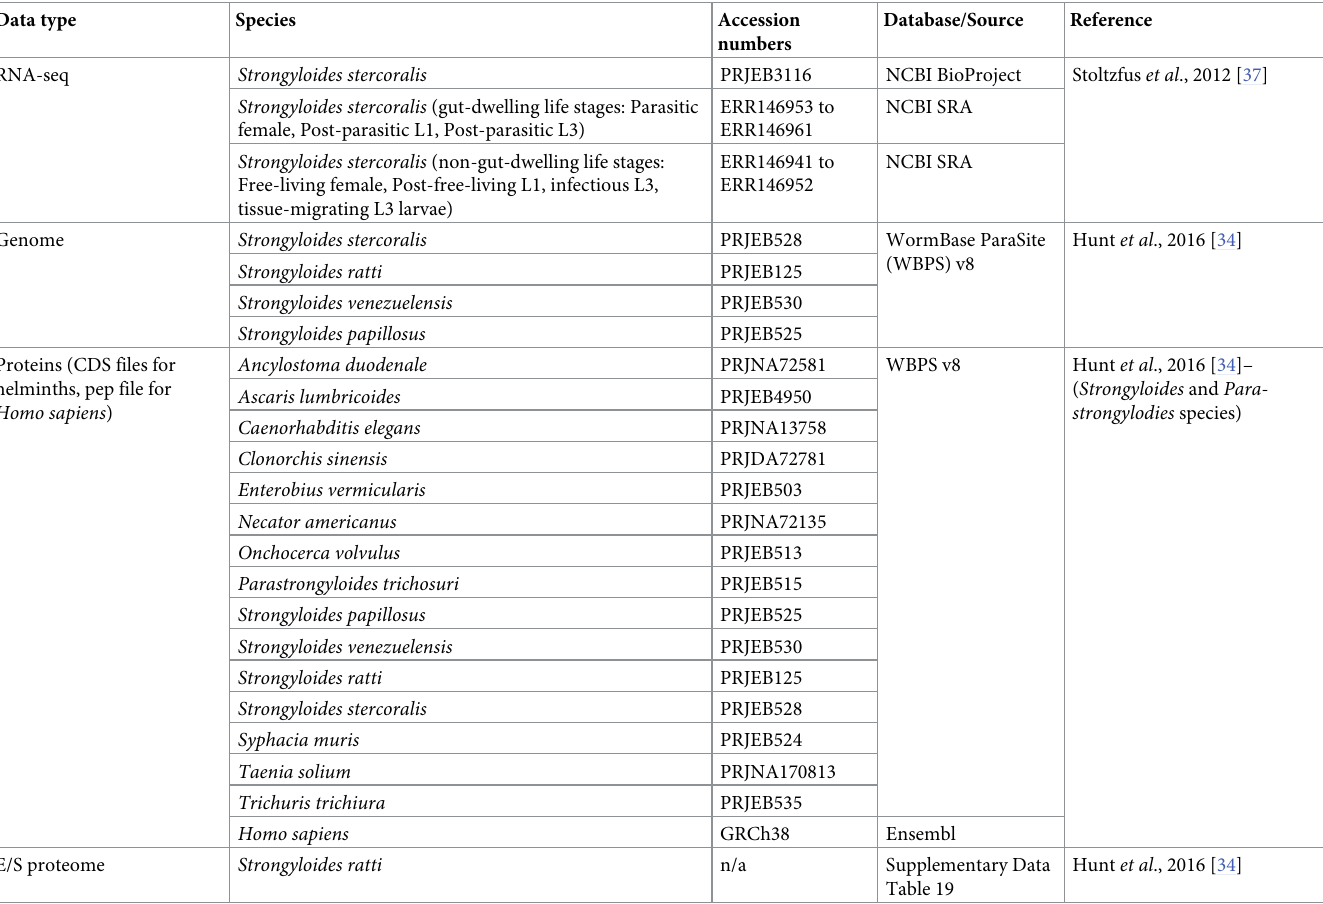
Table 1. Data used in this study. Accession numbers, source databases, and original references where used. CDS, coding sequence; NCBI SRA, National Centre for Bio- technology Information Sequence Read Archive. Data